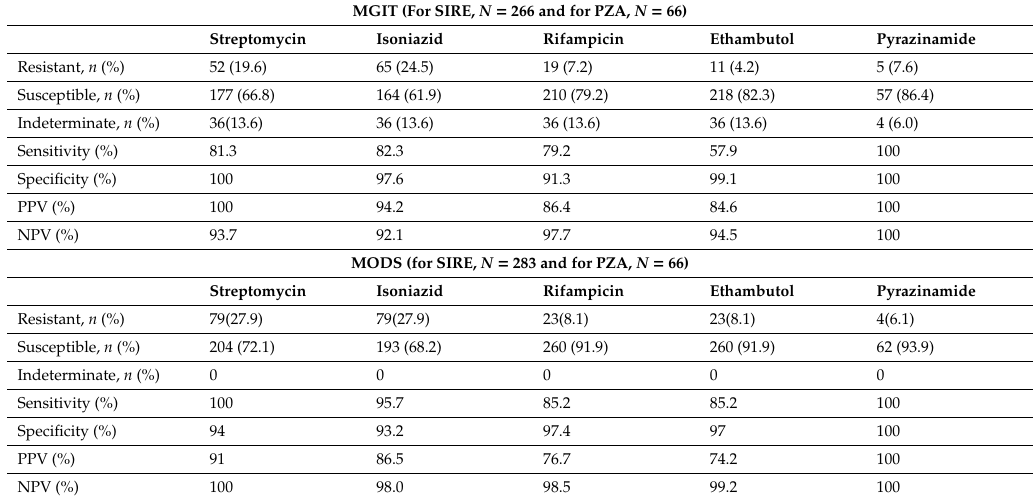
Table 2. Resistance pattern of the antimicrobials and sensitivity, specificity, and predictive values. MGIT (For SIRE, N = 266 and for PZA, N = 66) Streptomycin Isoniazid